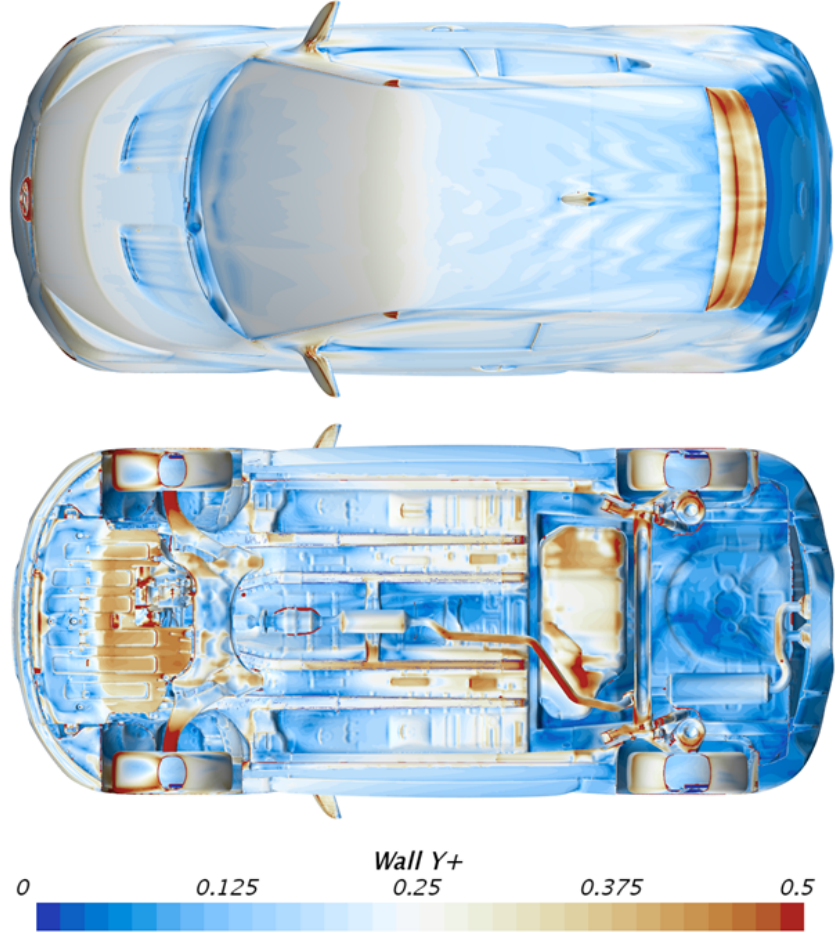
Figure 6. The wall y + values on the external surfaces of the